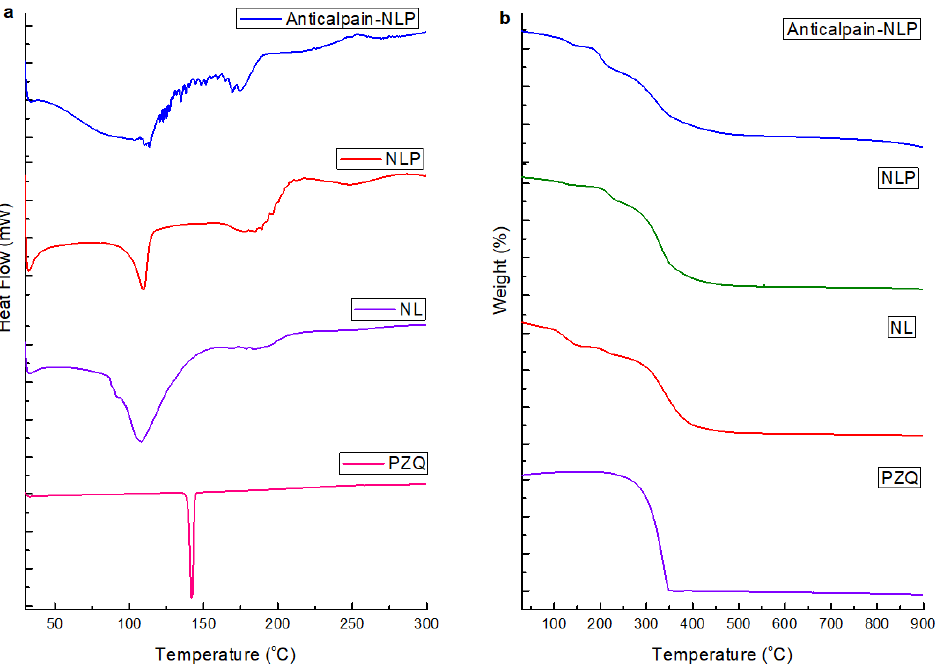
Figure 4. ( a ) DSC thermograms of PZQ, NL, NLP, and anti-calpain-NLP; ( b ) Thermogravimetric analyses of PZQ, NL, NLP and anti-calpain-NLP.